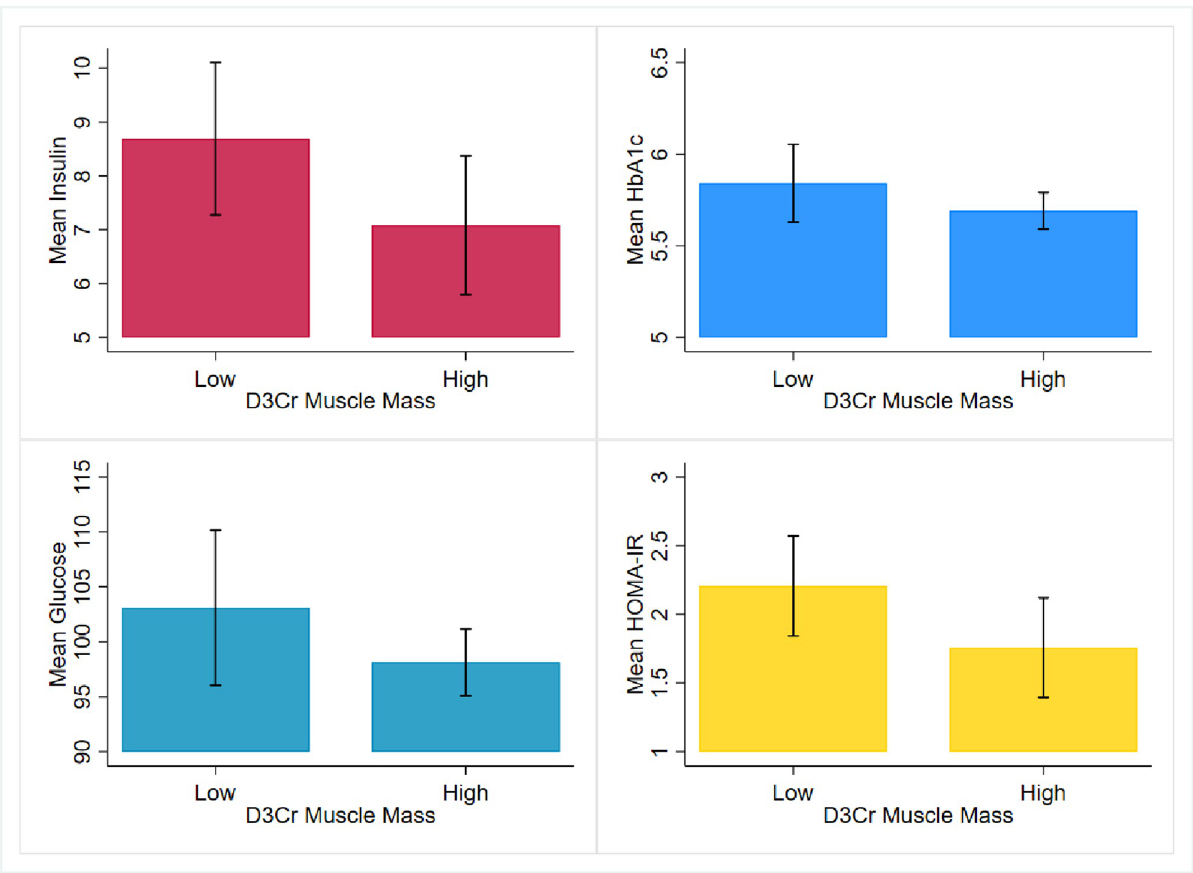
Fig 2. Comparison of mean values of insulin, HbA1c, glucose and HOMA-IR among postmenopausal women with low and high D 3 Cr muscle mass.